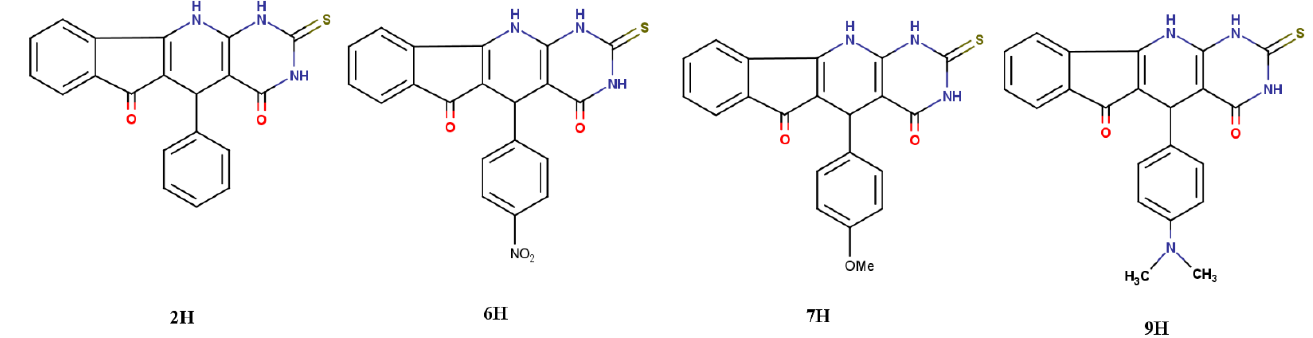
Figure 2. The 2D structure of the four thiouracil based dihydro-indenopyridopyrimidines (TUDHIPP) derivatives ( 2H, 6H, 7H , and 9H ).